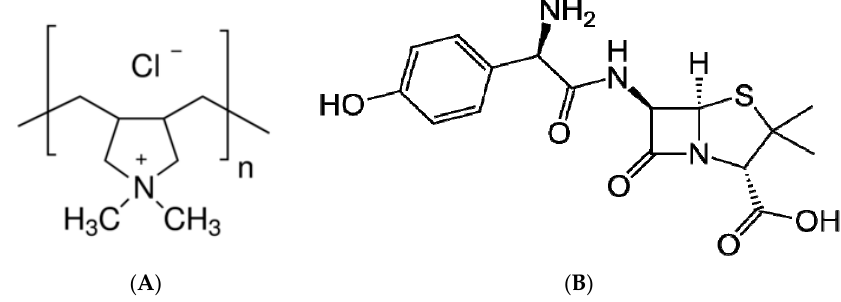
Figure 1. Chemical structure of polydiallyldimethylammonium chloride (PDADMAC) ( A ) amoxicillin (AMX) ( B ).